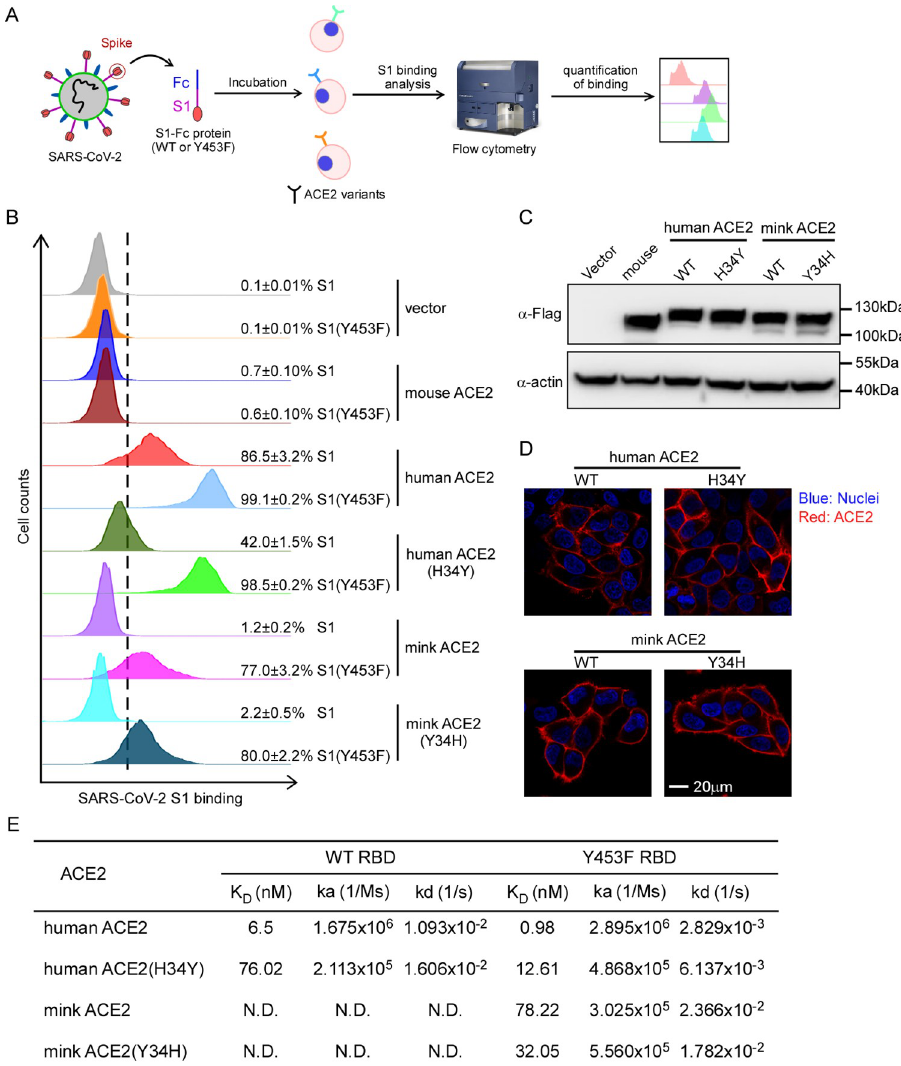
Fig 2. Increased binding of Y453F RBD protein to mink ACE2. (A) Schematic of testing the efficiency of ACE2 variants binding WT or Y453F viral spikes. (B) HeLa cells were transduced with human and mink ACE2 or their mutants as indicated. The transduced cells were incubated with the WT or Y453F S1 domain of SARS-CoV-2 C- terminally fused with a His tag and then stained anti-His-PE for flow cytometry analysis. Values are expressed as the percent of cells positive for S1-Fc among the ACE2-expressing cells (zsGreen1+ cells) and shown as the means ± SD from 3 biological replicates. These experiments were independently performed three times with similar results. (C) Representative immunoblots of HeLa cells transduced with lentiviruses expressing FLAG-tagged ACE2. Actin used as the loading control. These experiments were independently performed twice with similar results. (D) Cell surface localization of human and mink ACE2 and their mutants. HeLa cells were transduced with lentivirus expressing human or mink ACE2 and their mutants. Cells were incubated with rabbit polyclonal antibody against ACE2 and then stained with goat anti-rabbit IgG (H+L) conjugated with Alexa Fluor 568 and DAPI (1 μ g/ml). The cell images were captured with a Zeiss LSM 880 Confocal Microscope. This experiment was independently repeated twice with similar results and the representative images are shown. (E) Table summarizing biochemical results for ACE2 variants bound to WT or Y453F RBD. These experiments were independently performed three times with similar